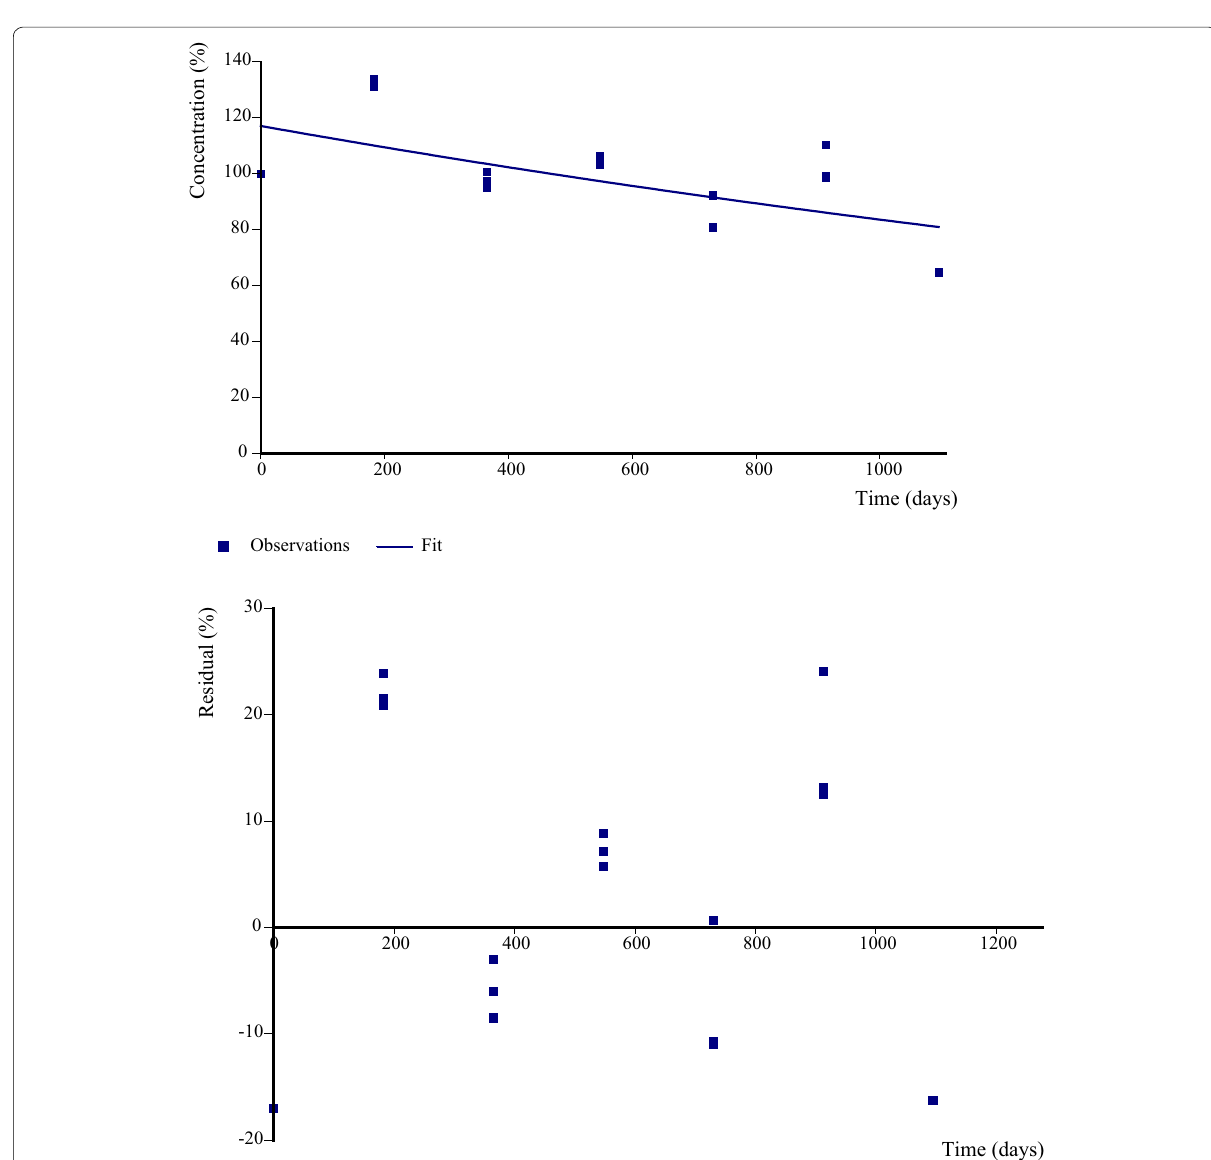
Fig. 9 CAKE model evaluation plot for disappearance of radioactivity (% aR) from the top 0–10 cm lysimeter layer. Observations and fitted model (above), residuals (below). Kinetic model: single first order. Prob > t : 0.001. Parent rate constant: 3.5e